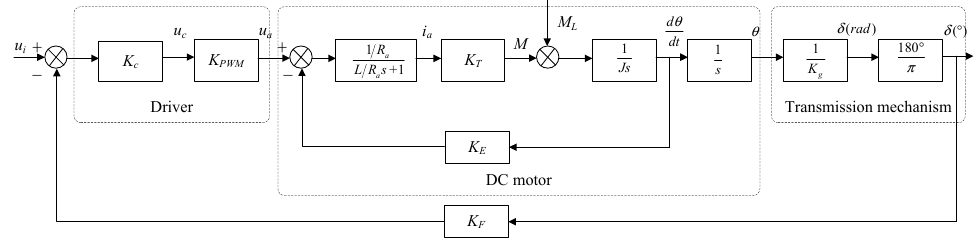
Figure 1. Transfer function block diagram of the electric steering gear drive system.